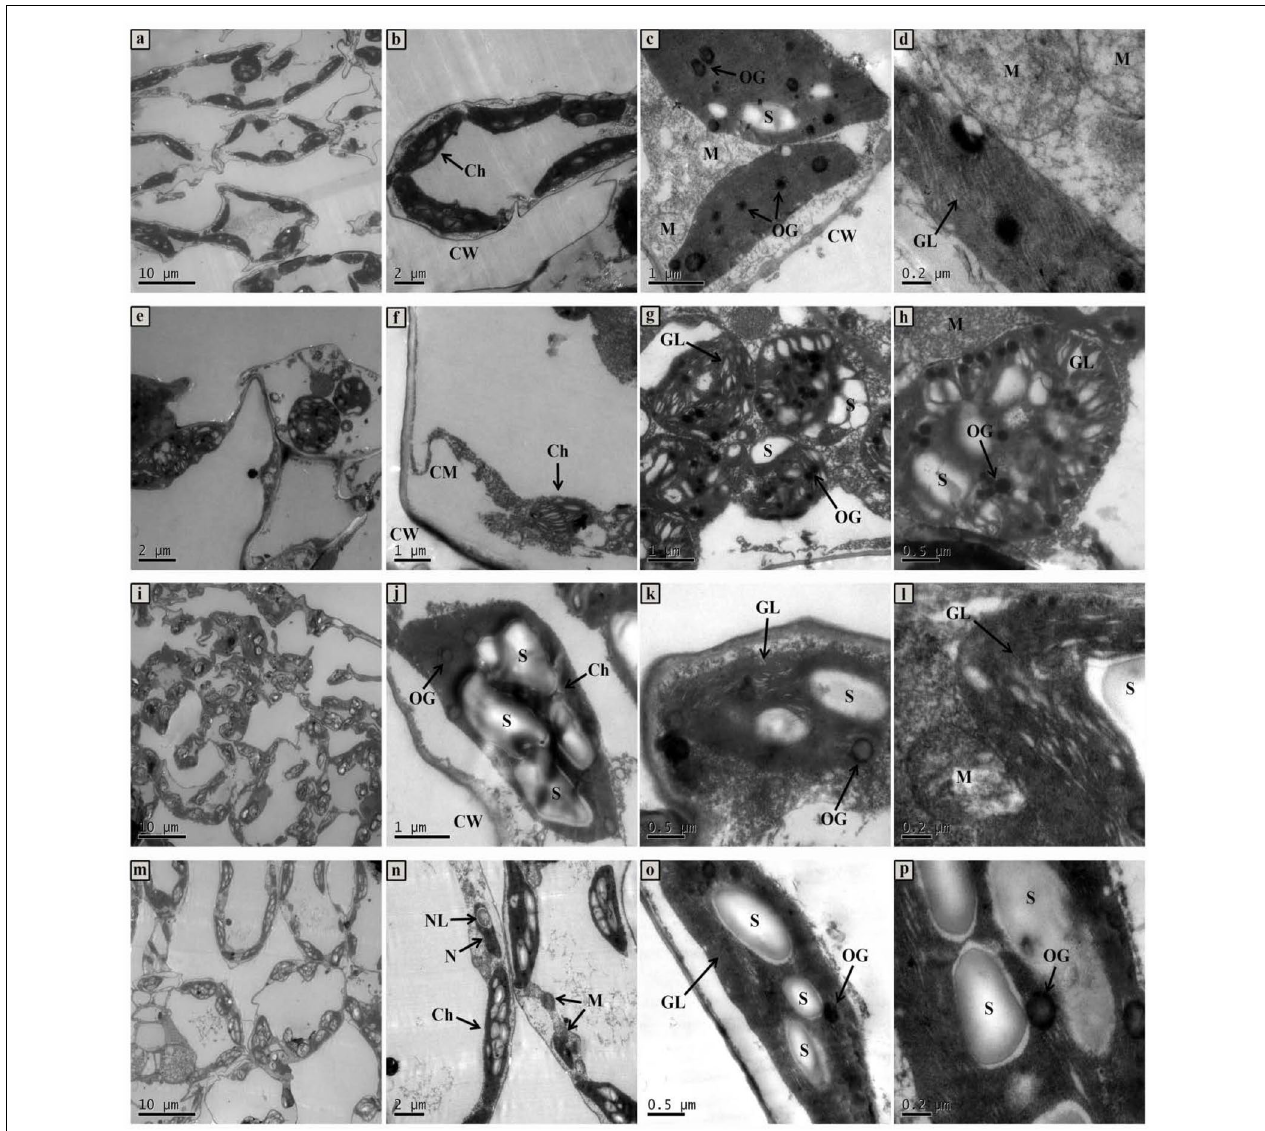
FIGURE 7 | The ultrastructural observation of mesophyll cell and chloroplast of cucumber seedlings. (a–d) Seedlings grown in normal condition. (e–h) 50 mmol L − 1 NaCl treated seedlings. (i–l) Seedlings treated with 50 mmol L − 1 NaCl and 25 mg L − 1 ALA simultaneously. (m–p) Seedlings sprayed 25 mg L − 1 ALA only. Abbreviations: CW, cell wall; CM, cell membrane; N, nucleus; NL, nucleolus; Ch, chloroplast; OG, osmiophilic globules; GL, grana lamella; S, starch; M,